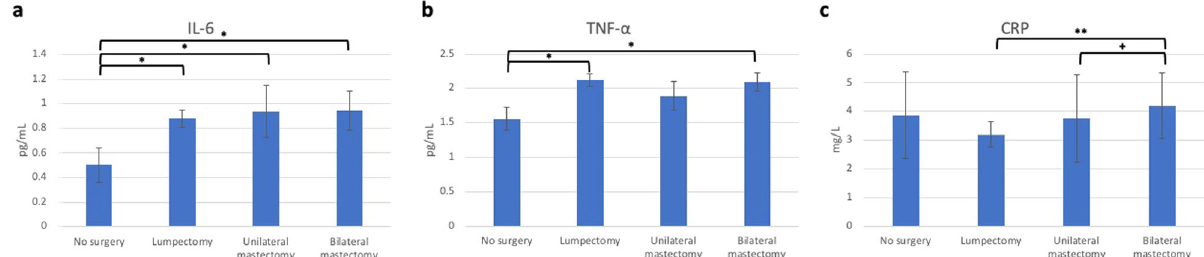
Fig. 4 Study 2 in fl ammatory markers. Average levels of IL-6 ( a ), TNF- α ( b ), and CRP ( c ) are presented with error bars representing standard errors. Statistically signi fi cant differences between groups are represented by bars with * indicating statistically signi fi cant differences using ANCOVA (* = p < 0.05, ** = p < 0.01) and + indicating a marginally signi fi cant difference ( + = p =